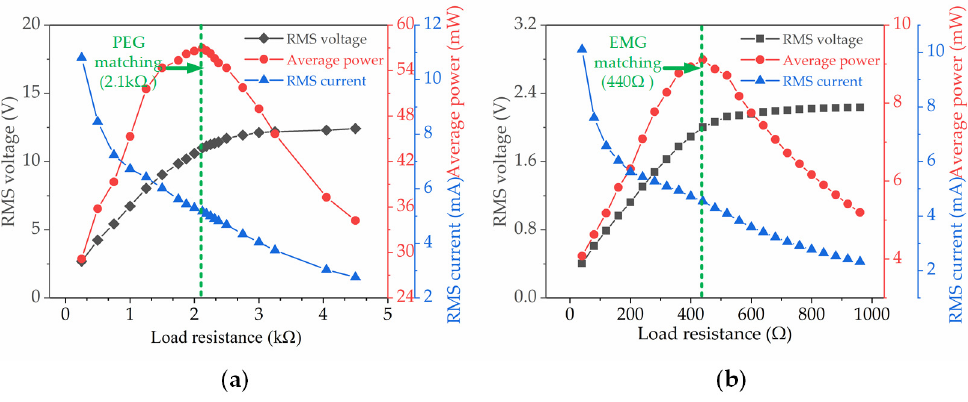
Figure 8. The output voltage, current and power across varied load resistances: ( a ) PEG; ( b ) EMG.